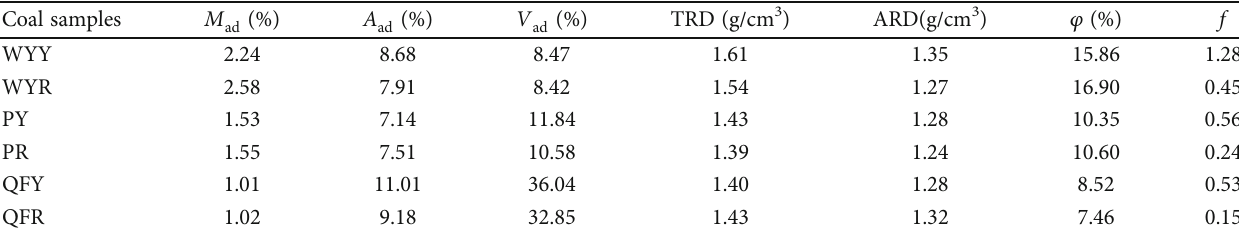
Table 1: The basic parameters of coal